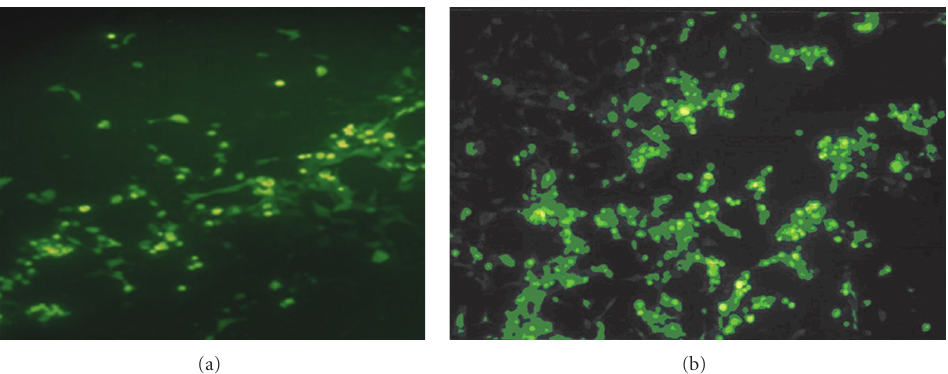
Figure 2: Adenovirus-producing foci after transfection of 293 cells, (a) 2 days after transfection; (b) 7 days after transfection (CPE).